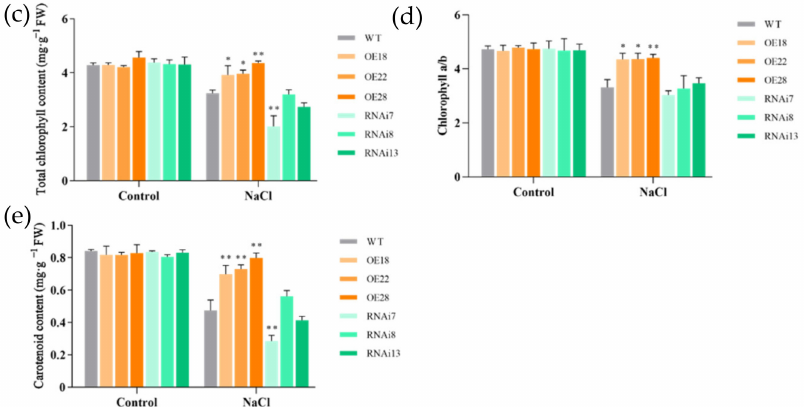
Figure 3. Effects of NaCl treatment on the photosynthetic pigment content of wild-type (WT), overex- pression (OE18, OE22, and OE28), and RNAi lines (RNAi7, RNAi8, and RNAi13). ( a ) Chlorophyll a content, ( b ) chlorophyll b content, ( c ) total chlorophyll content, ( d ) chlorophyll a and b, and ( e ) carotenoid content were determined after 6 d of NaCl treatment. The experiment was repeated three times, and each treatment included four replications. Data are means ± SE ( n = 4). An as- terisk indicates a significant difference (LSD test, * p < 0.05 and ** p < 0.01) between wild-type, overexpression, and RNAi lines.